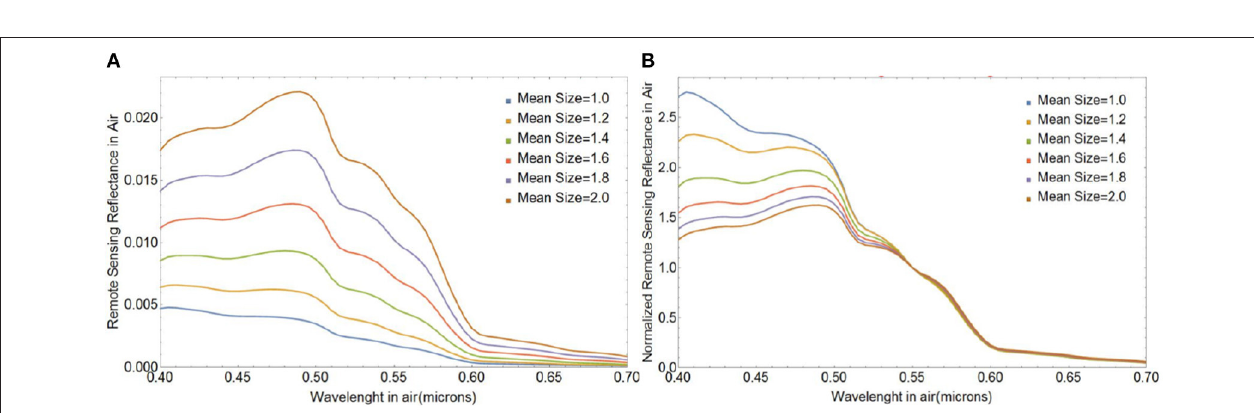
FIGURE 9 | Spectral above-water remote sensing reflectance R rs ( λ ) in absolute values of sr − 1 (A,C) and normalized at 0.55 µ m (B,D) for various fractions of naked cores ( F nc 0 to 1, top row), and various surviving core fractions ( F sc 0 to 1, bottom row). We used a size distribution of free liths of mean a 0 1.7 µ m and standard = = deviation of 0.15 µ m, an initial coccolithophore cell concentration of 10 9 m − 3 and four layers of liths.